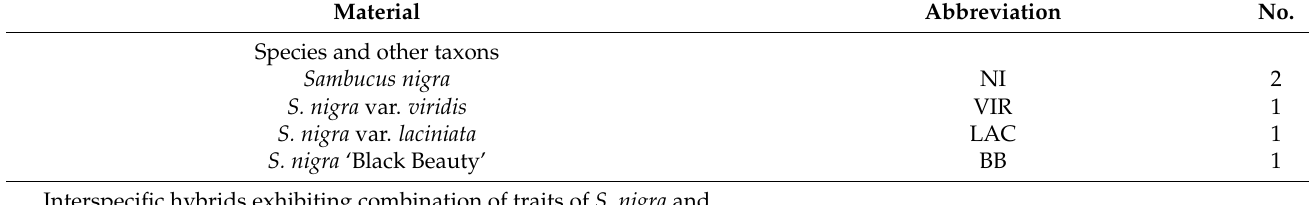
Table 3. Elderberry species and interspecific hybrids included in the